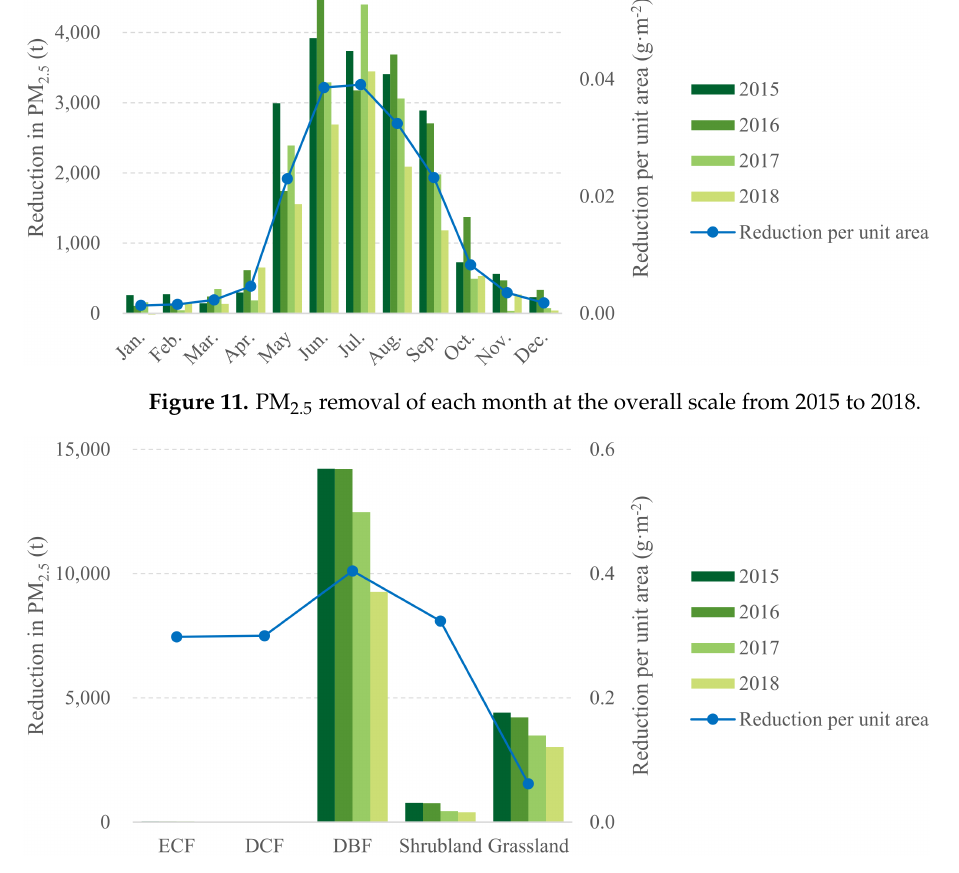
Figure 12. PM 2.5 removal of each vegetation type at the overall scale from 2015 to